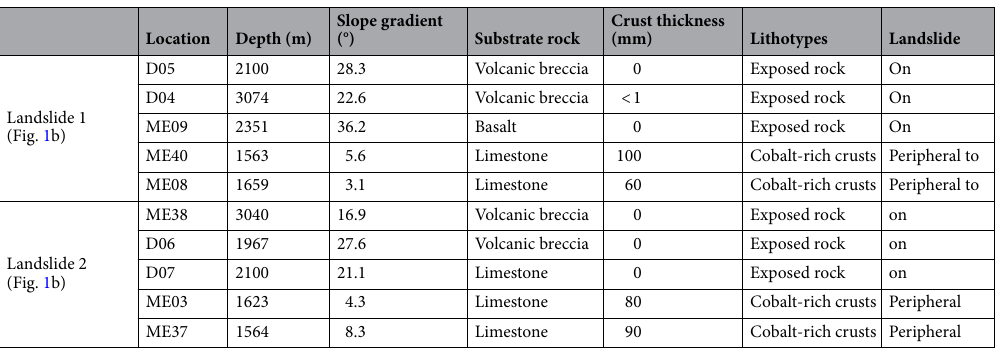
Table 1. Survey samples on or next to the landslides shown in Fig. 4 and their characteristics.